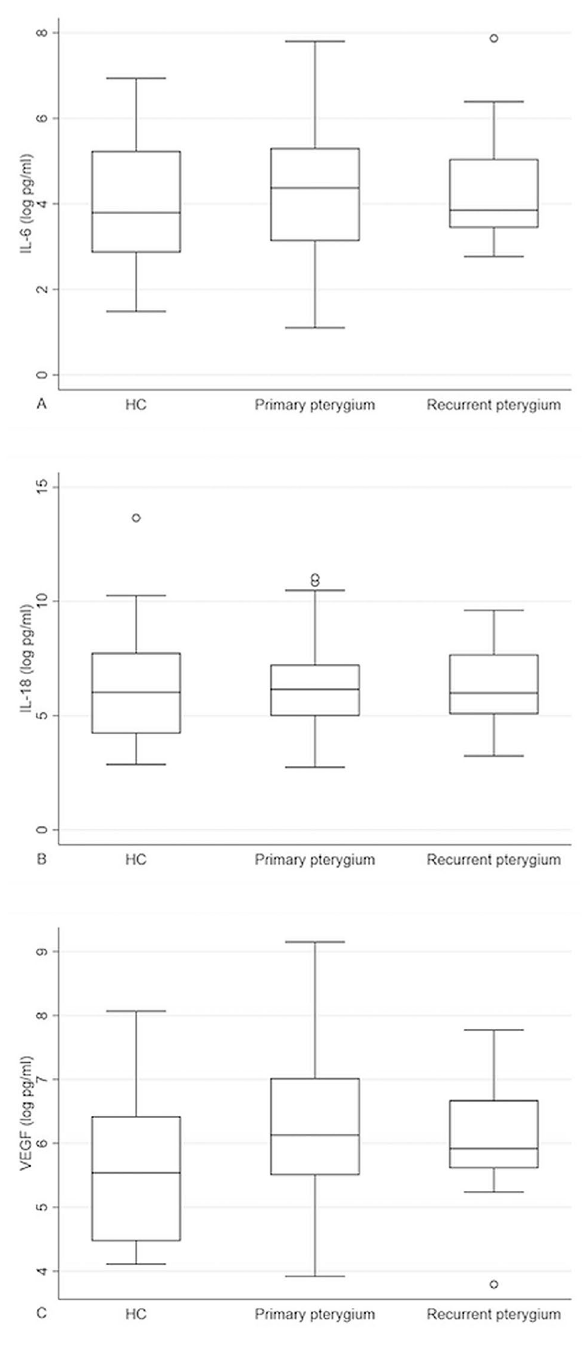
Figure 1. Boxplot of tear cytokine concentration (after logarithmic transformation) in healthy control, primary pterygium, and recurrent pterygium groups. ( A ) Tear IL-6 concentration in each group; ( B ) Tear IL-18 concentration in each group; ( C ) Tear VEGF concentration in each